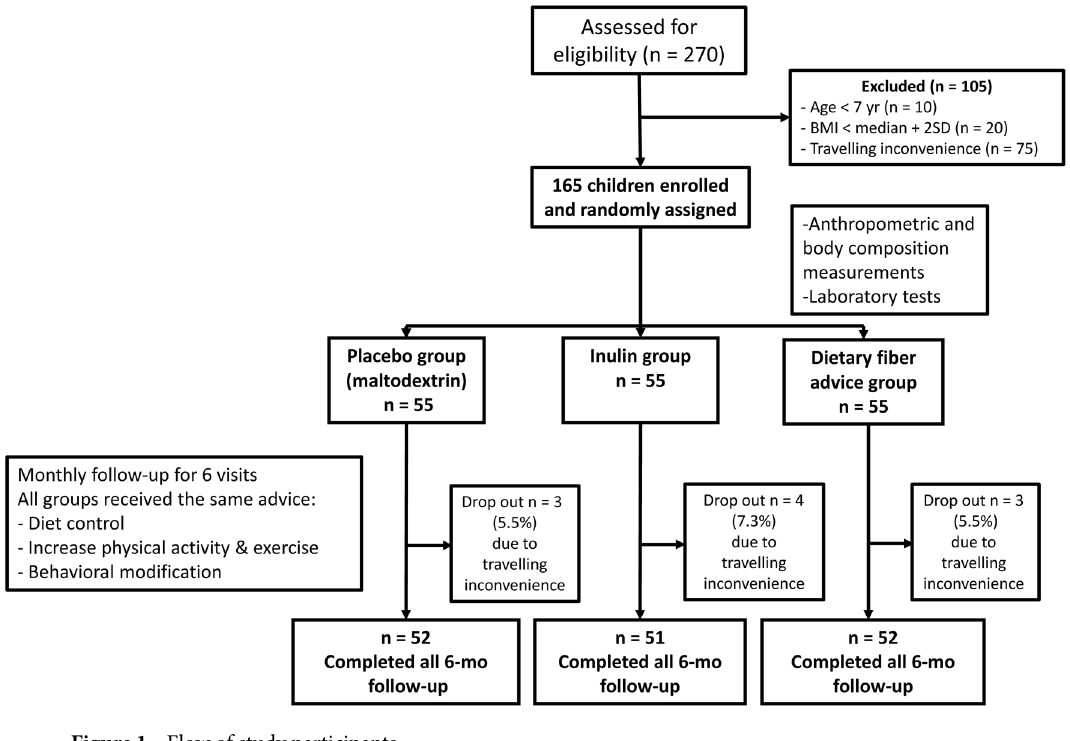
Figure 1. Flow of study